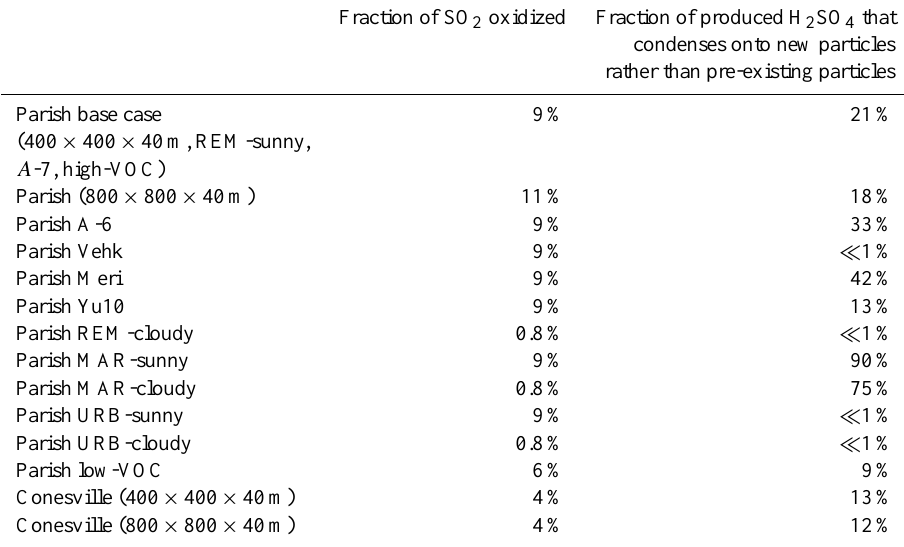
Table 2. Fraction of SO 2 oxidized and fraction of produced H 2 SO 4 that condenses onto new particles rather than pre-existing particles within 50km for each model simulation. The labels 400 × 400 × 40m and 800 × 800 × 40m refer to the two model resolutions used in this study. The A -6, Vehk, Meri, and Yu10 nucleation schemes are discussed in Sect. 4.1. The REM, MAR, and URB aerosol backgrounds are discussed in Sect. 4.2. The sunny and cloudy cases and the high-VOC and low-VOC cases are discussed in Sect.